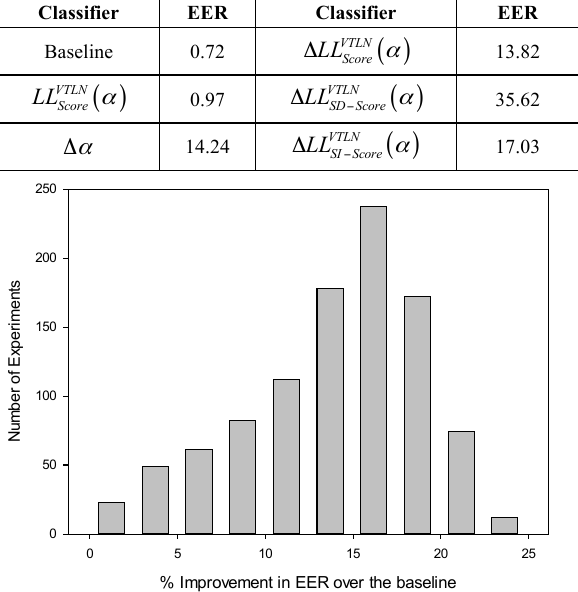
Figure 4. Histogram for improvements over the baseline system for the